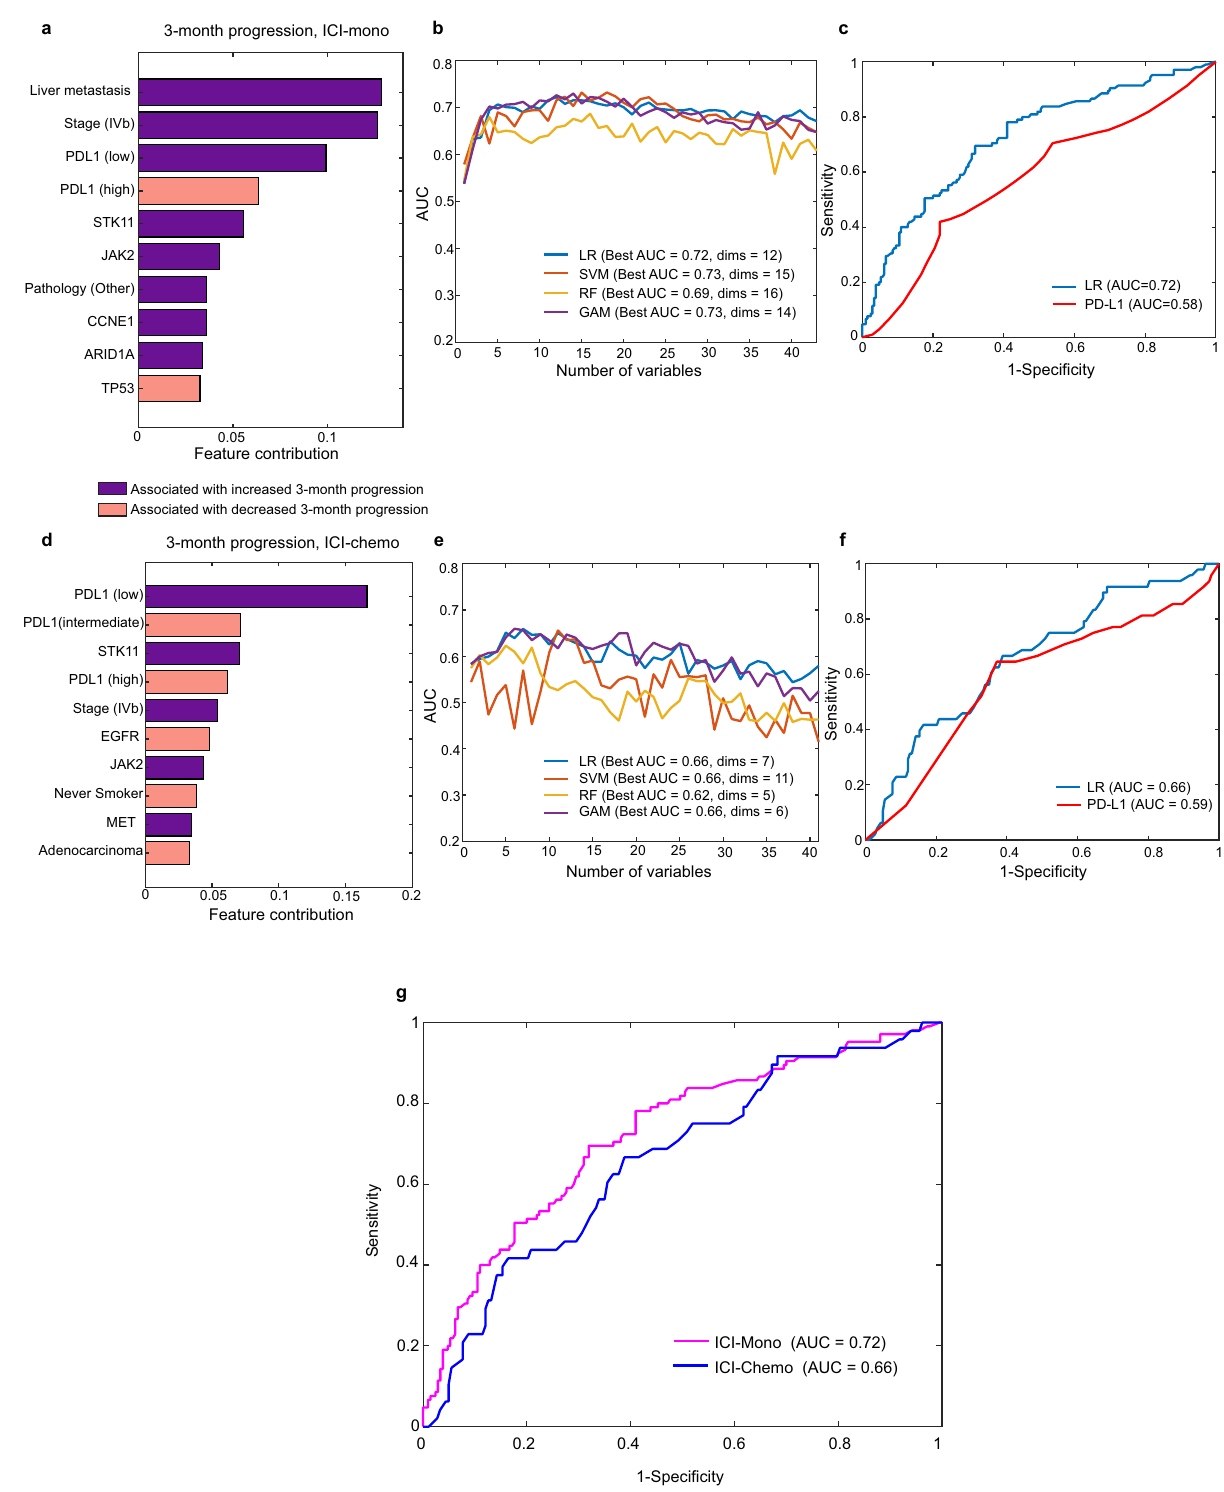
Fig. 6 | Predictive models of 3-months progression on MDACC-primary cohort (training cohort) by logistic regression (LR), support vector machines (SVM), random forest (RF), and generalized additive model (GAM) for clin- icopathological and genomic variables in immune checkpoint inhibitor (ICI) monotherapy (ICI-mono; a – c) and ICI with concurrent chemotherapy (ICI- chemo; d – f) treated patients. a Bar chart showing the contribution of features with signi fi cant p -value from chi-squared feature selection; positive association with 3-month progression (worse effect) shown in purple, negative association